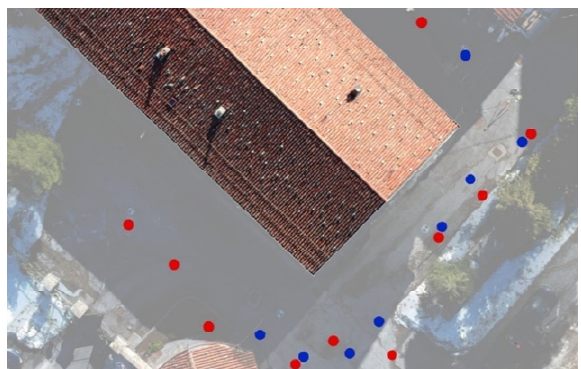
Figure 13. Positions of the X 330 scans (red) and the BLK360 scans (blue).